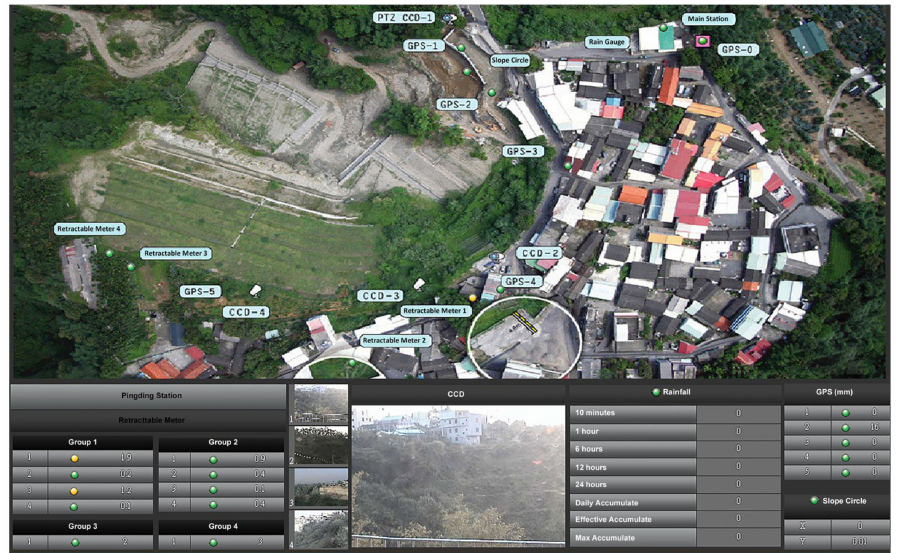
Figure 10. Integrated monitoring data display.